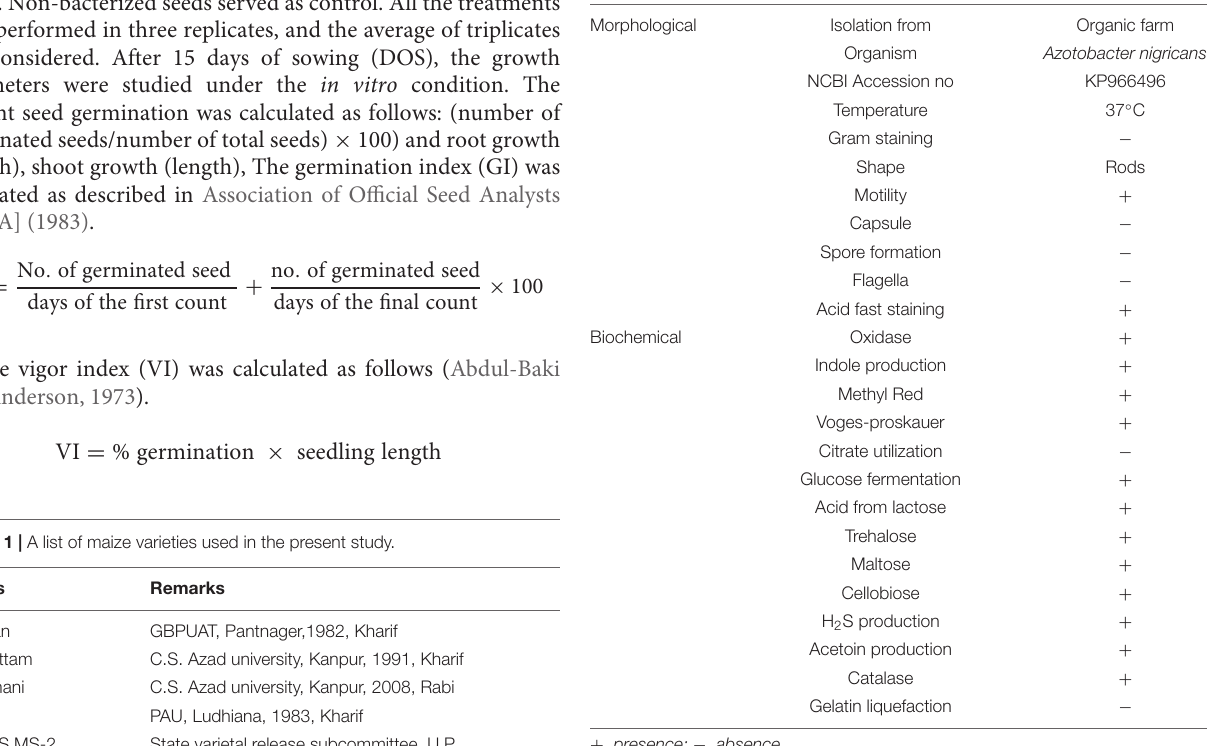
TABLE 1 | A list of maize varieties used in the present study.